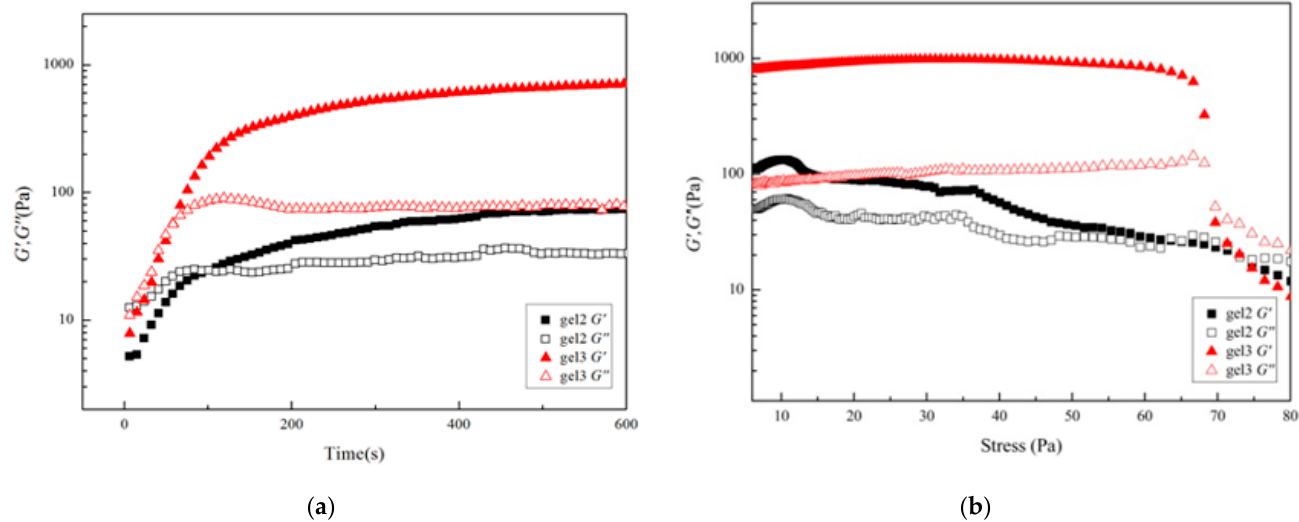
Figure 12. Rheological images of gel2 and gel3 at a constant temperature of 37 °C with ( a ) time scanning, ( b ) stress scan- ning.